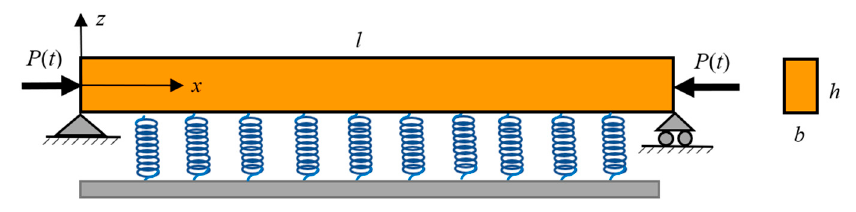
Figure 1. Embedded nonlocal Reddy beam under axial excitation.